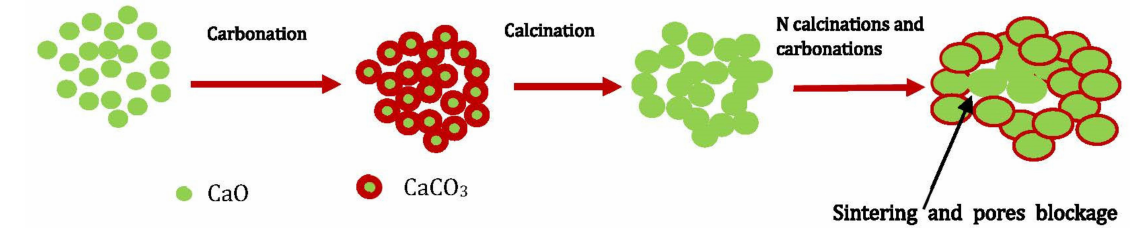
Figure 7. Scheme of CaO and CaCO 3 particles along the carbonation–calcination cycles.